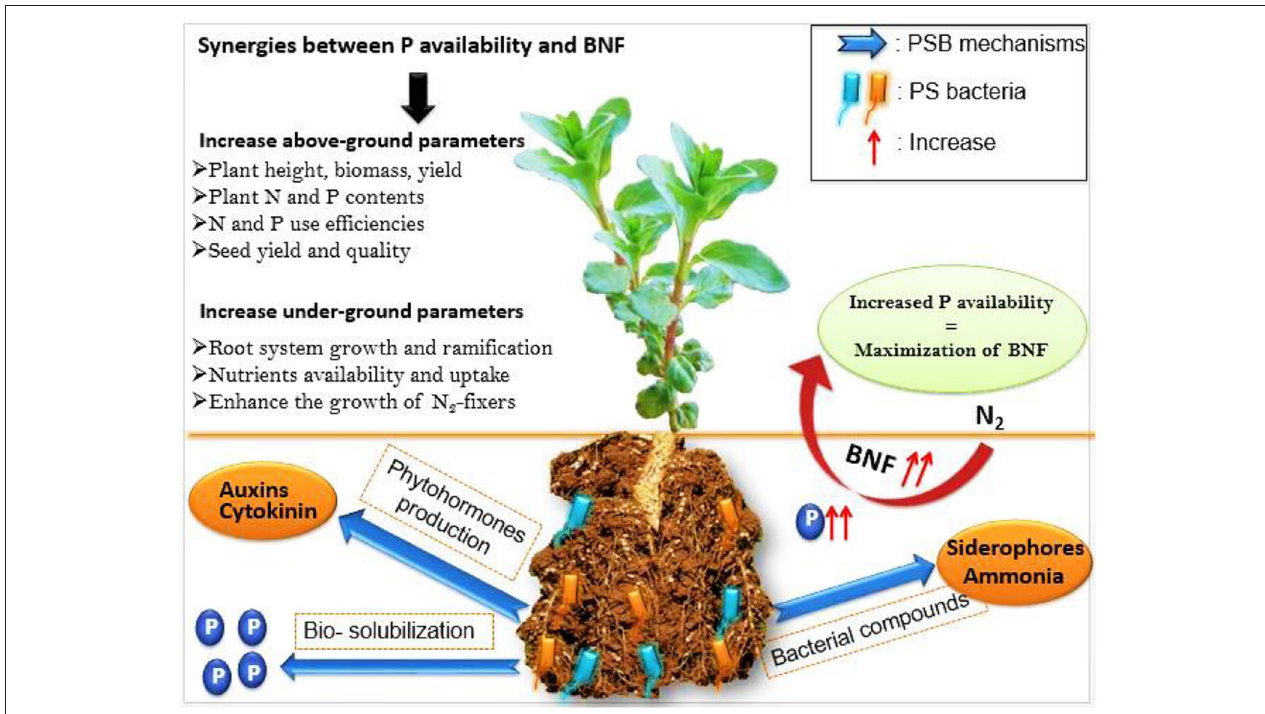
FIGURE 1 | Interactions between PSB and legumes nodulated roots and their effects on nutrients availability and the overall plant growth